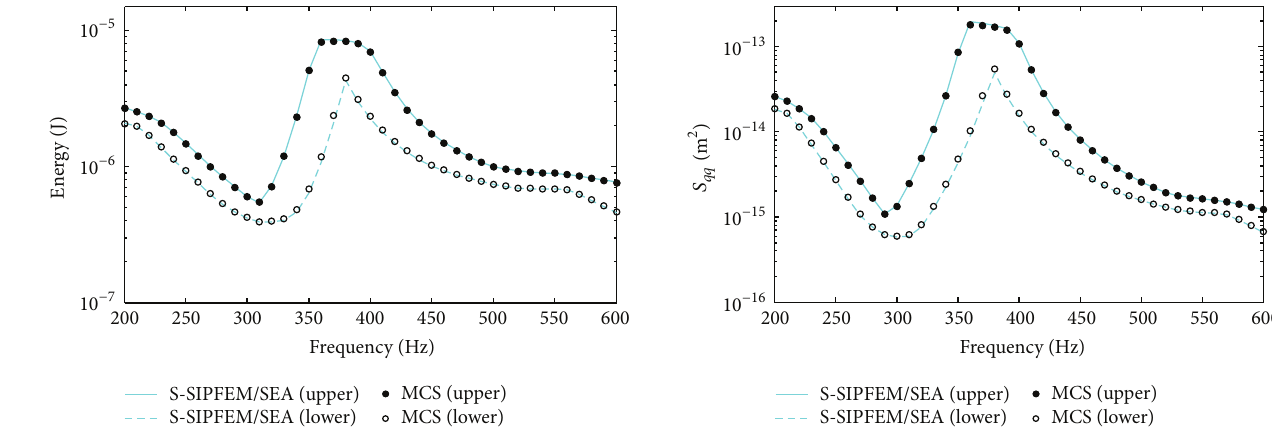
Figure 9: The bounds of the plate energy with three subintervals. Figure 10: The bounds of the autospectra of the driving point displacements with three